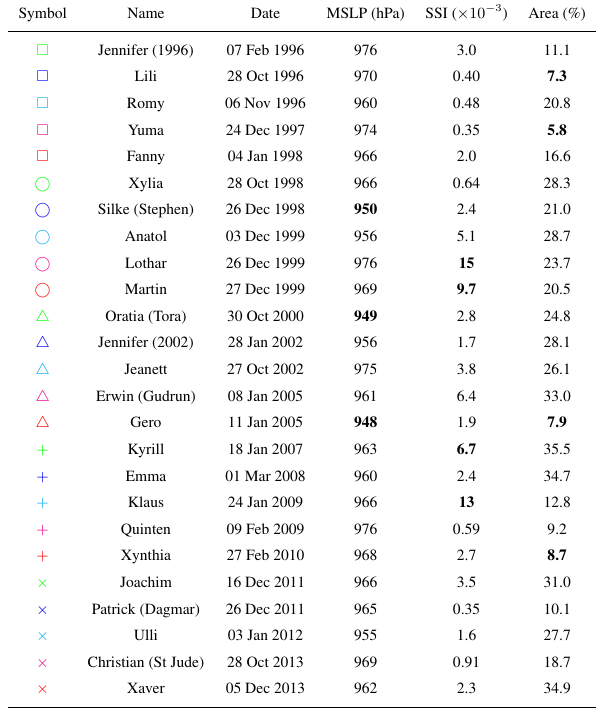
Table 1. Chronological list of the 25 investigated storms with their characteristics in ERA-Interim on the day of maximum in- tensity: minimum mean-sea-level pressure (MSLP), Storm Severity Index (SSI) and area of central Europe covered by gusts exceeding the local 98th percentile. The values corresponding to the deepest, most severe and smallest storms cited in the text are emphasized in